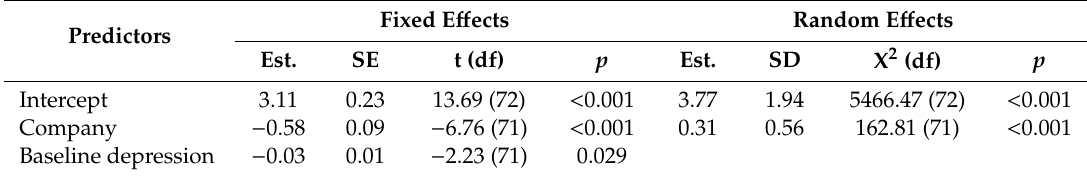
Table A2. Parameter estimates for multilevel model A.2.